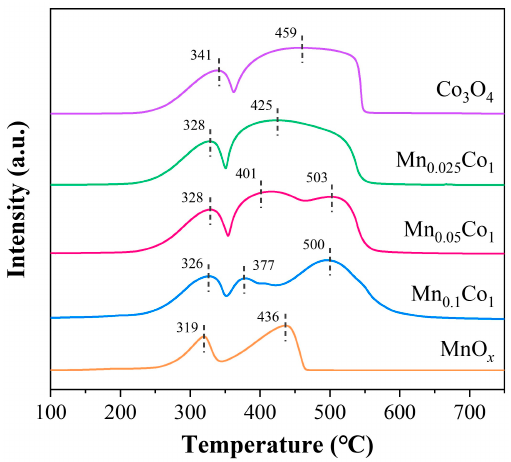
Figure 4. H 2 -TPR profiles of Co 3 O 4 and Mn x Co 1 ( x = 0.025, 0.05, 0.1) catalysts.